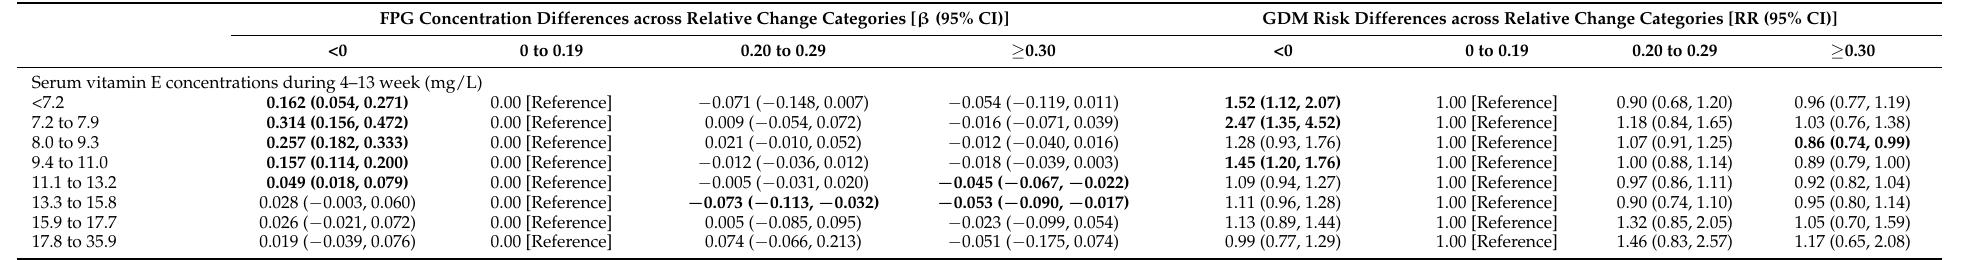
Table 3. Adjusted relative risks (95% CI) for GDM according to gestational vitamin E (VE) changes stratified by the first-trimester VE concentration categories. FPG Concentration Differences across Relative Change Categories [ β (95%